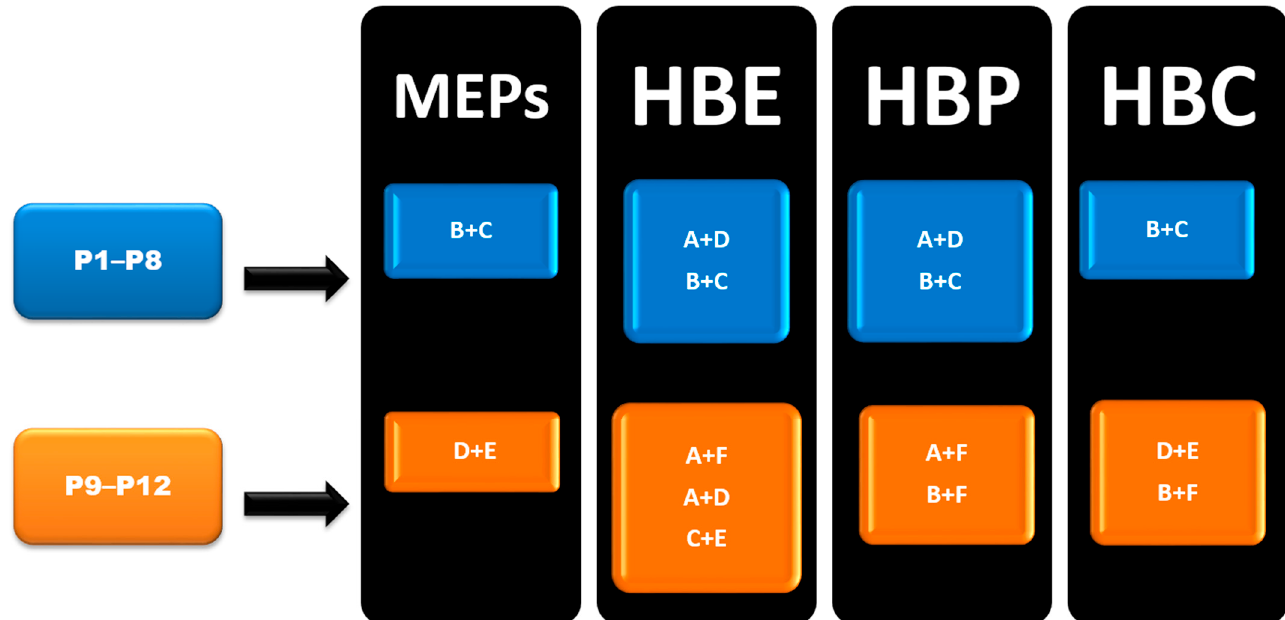
Figure 6. Summary of synthons predicted in P1 – P12 .